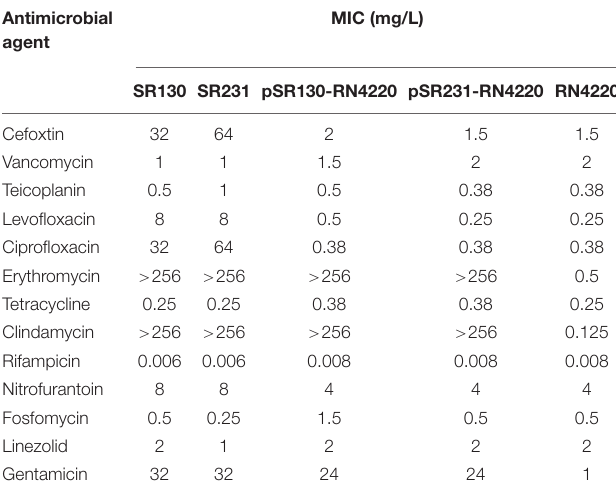
to sugar metabolism and amino acid metabolism,